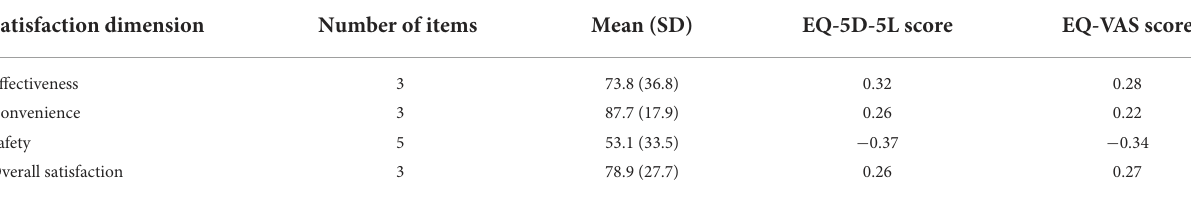
TABLE 4 Pearson correlation coefficient between treatment satisfaction and